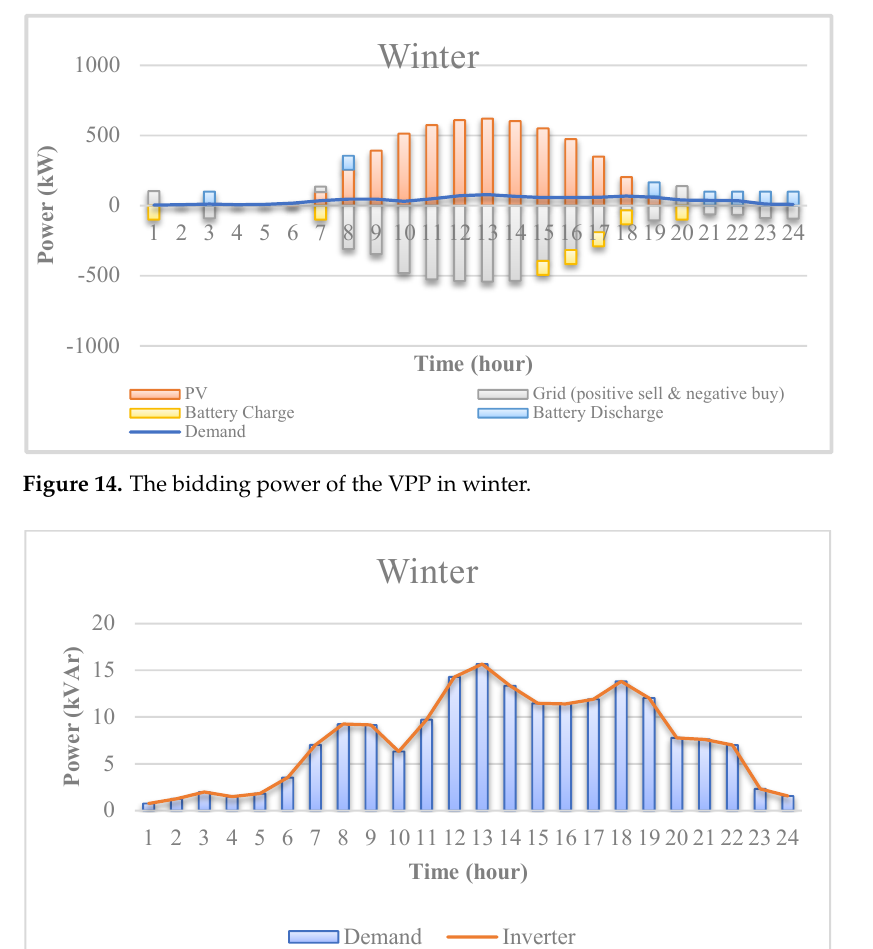
Figure 17. The reactive power support by smart inverters in spring. The amount of profit which a VPP can achieve is summarised in Table 4. As can be seen from this table, the model VPP could achieve a daily profit of $115/day. In other words, it can be approximately $40 k over a year. From this it can be concluded that VPPs bring a lot of advantages, such as reactive power support, profit maximising, etc. The effect of the PV inverter on the voltage profile of the network is also investigated here. In order to recognise what impact the PV inverter may have on the controlling volt- age, the reactive power demand is increased at some hours. The voltage profile of the VPP is illustrated to distinguish it from the controlling voltage of the PV inverters. Here, the reactive power demand of the VPP rises/decreases at hours 5, 10 and 15. The results for summer are provided in Figures 18 and 19. From these figures, it is clear that the voltage at each of these points leveled out over the period, meaning that PV inverters can maintain the voltage of the VPP within acceptable ranges by injecting/absorbing reactive power, as shown in Figure 19. Table 4. The summation of profit of the model VPP for different seasons. Seasons